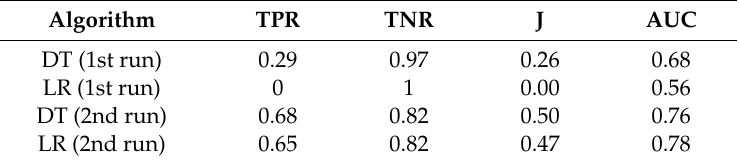
Table 2. Algorithm classification